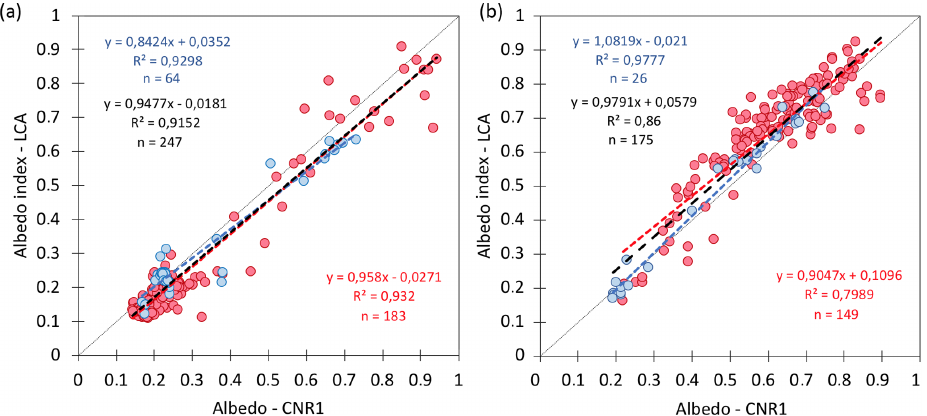
Figure 6. ( a ) Comparison of the daily measured albedo at the ORE site using the CNR1 radiometer and the LCA for the period from 7 November 2012 to 6 March 2013; daily data calculated from 11:00 to 15:00; RMSD = 0.1; n = 247. ( b ) Comparison of the daily measured albedo at the SAMA site on the Zongo Glacier using the CM3 sensor and LCA for the period from 1 December 2012 to 9 October 2013; daily data calculated from 11:00 to 15:00; RMSD = 0.08; n = 175. The red dots are for cloudy conditions and the white dots are for sunny conditions, as per the classification given by Sicart et al. (2016). The calculated regression lines are shown in red for cloudy conditions, blue for sunny conditions, and black for all conditions. The dotted lines represent the